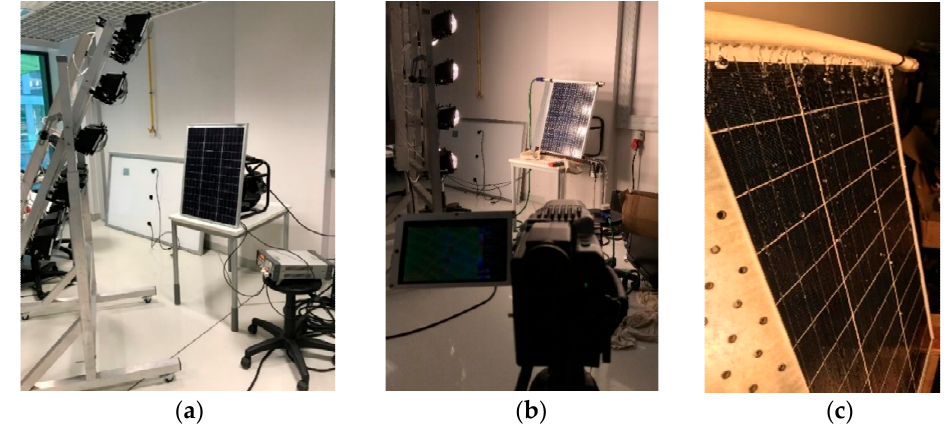
Figure 4. Experimental rig no. 1: ( a ) general view of the experimental rig no. 1, ( b ) experimental rig during tests with an infrared camera, ( c ) a part of the water cooling system (header) installed on the tested 50 Wp PV panel.